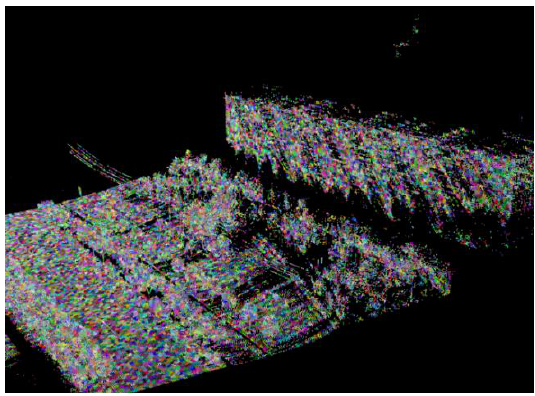
Figure 3. Super-voxel clustering